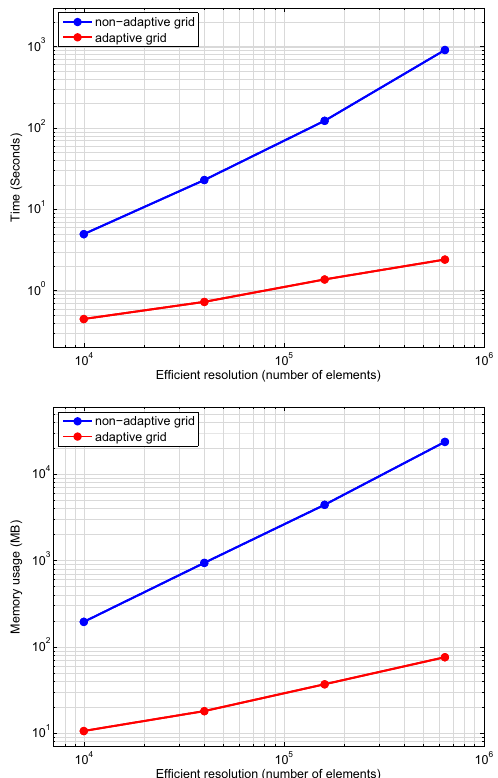
Figure 33. Time ( top ) and memory requirements ( bottom ) for Cholesky factorization depending on numerical resolution. Quad AMD Opteron 8220 system was